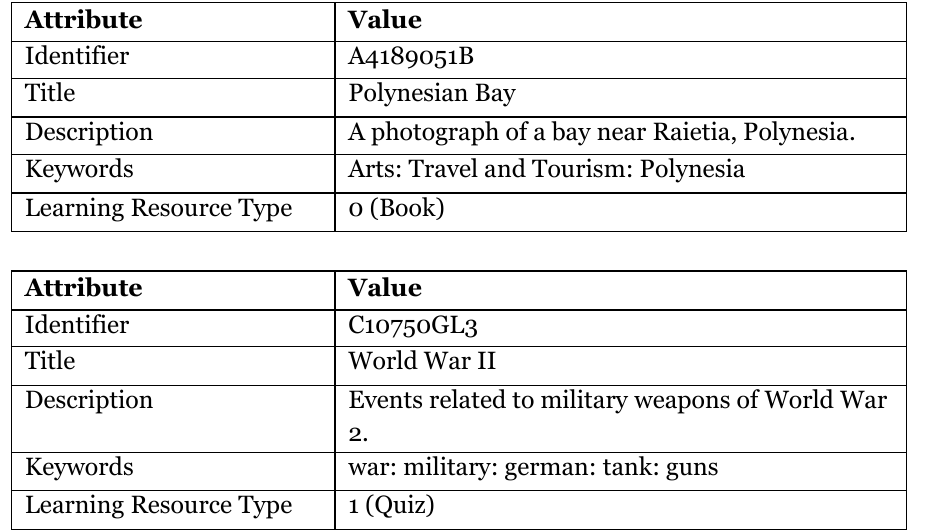
Example of the Five Attributes of Table 3, on LO Taken from Specific